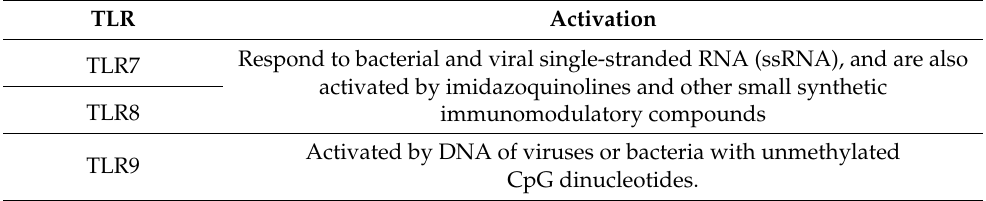
Table 1. Activation of TLRs in mammals [41–43].